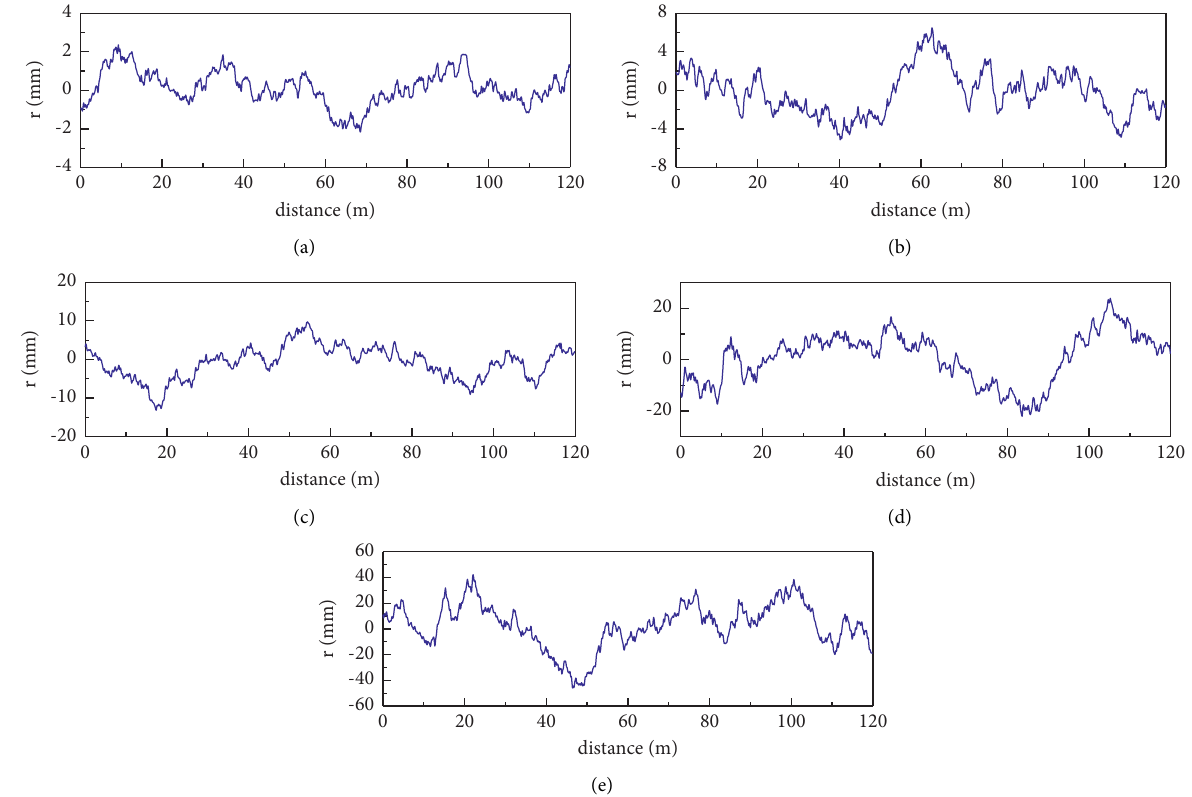
Figure 2: Road roughness of various roughness classes: (a) class A: very good; (b) class B: good; (c) class C: average; (d) class D: poor; (e) class E: very